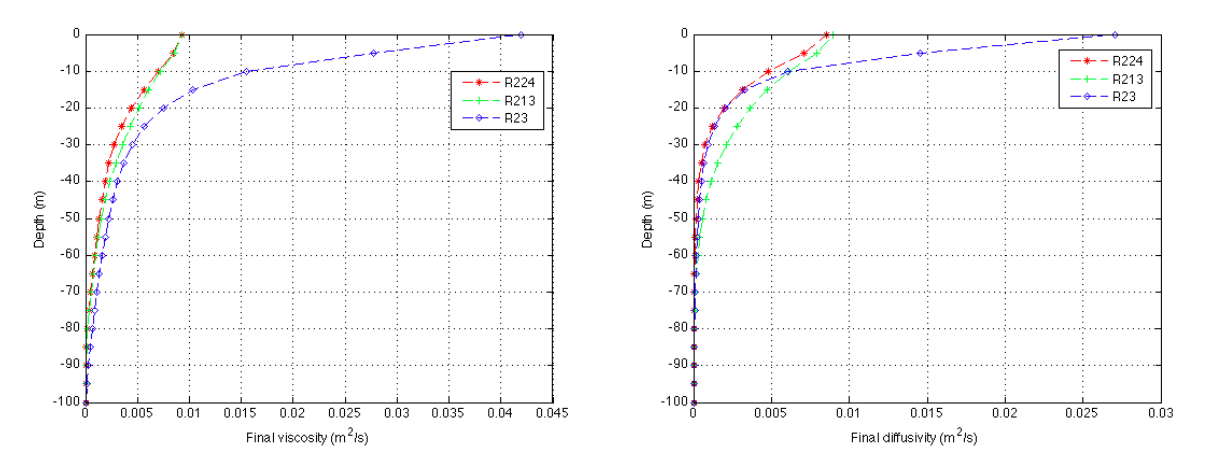
Fig. 4. Test 1: mixing-layer viscosity (left) and diffusivity (right) for models R 224, R 213 and R 23.